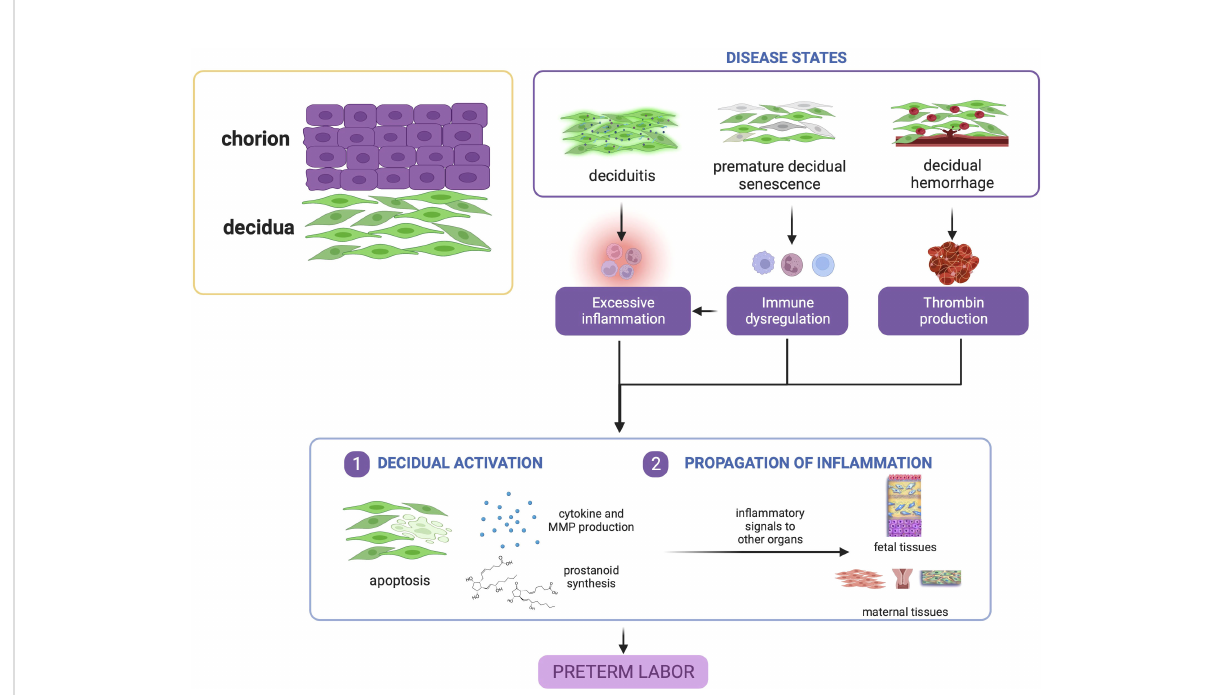
FIGURE 3 Disease states in the decidua contribute to preterm birth. Deciduitis, decidual hemorrhage, and premature decidual senescence all eventually converge towards premature decidual activation characterized by leukocyte activation, in fl ammatory mediator production, and decidual apoptosis. This fi gure was created with